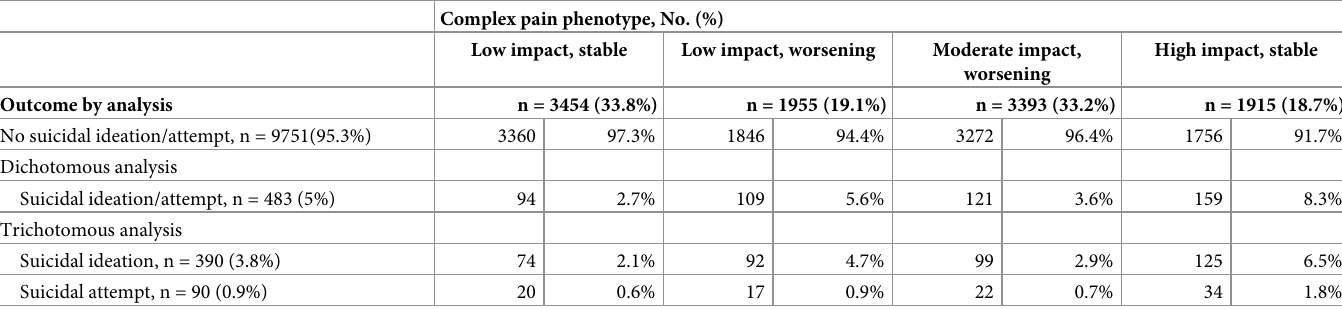
Table 2. Dichotomous and trichotomous analysis suicidal ideation and/or attempt by complex pain phenotype. Complex pain phenotype, No.